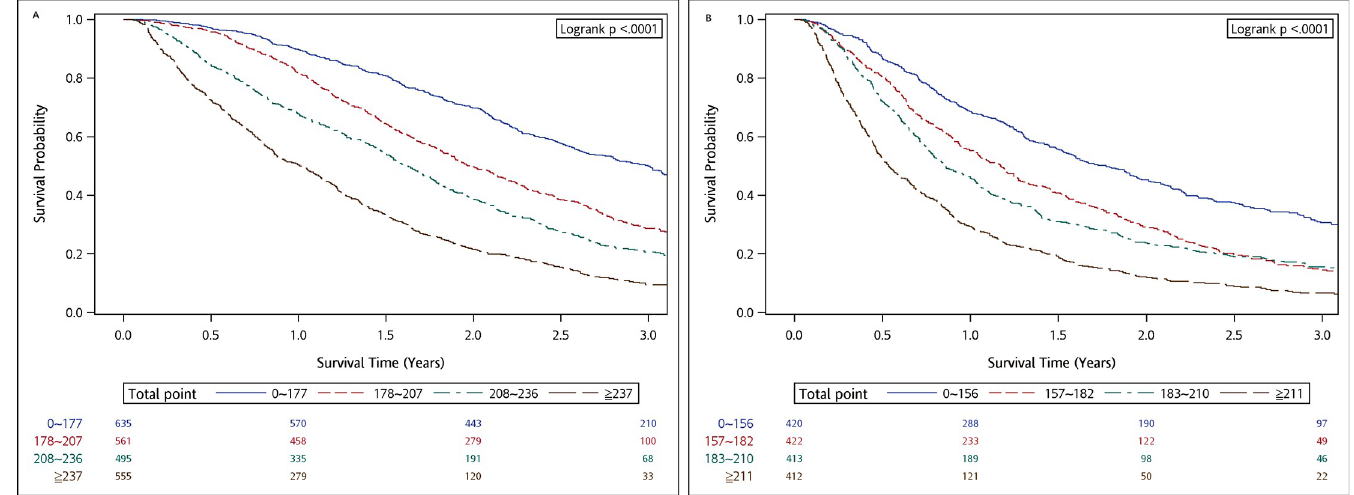
Fig 2. Survival probability (according to quartiles of total points) for 1-year survival. (A) EGFR mutation positive (EGFR(+)) patients. (B) EGFR wild-type (EGFR (-)) patient. The quartiles of EGFR mutation positive patients is defined as follows: quartile 1: 0 to 177 points; quartile 2: 178–207 points; quartile 3: 208–236 points; quartile 4: ≧ 237 points. The quartiles of EGFR wild-type patients defined as follows: quartile 1: 0 to 156 points; quartile 2: 157–182 points; quartile 3: 183–210 points; quartile 4: ≧ 211 points.